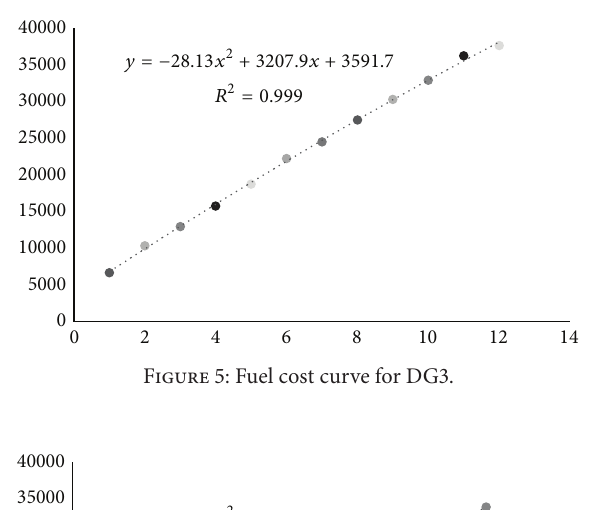
Figure 4: Fuel cost curve for DG2.